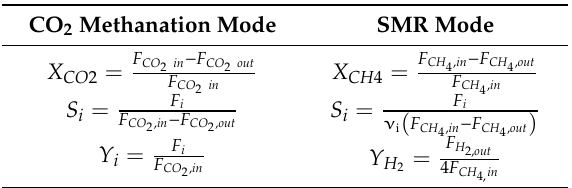
Table 3. Conversion, selectivity and yield defined for MCO2 and SMR reaction schemes